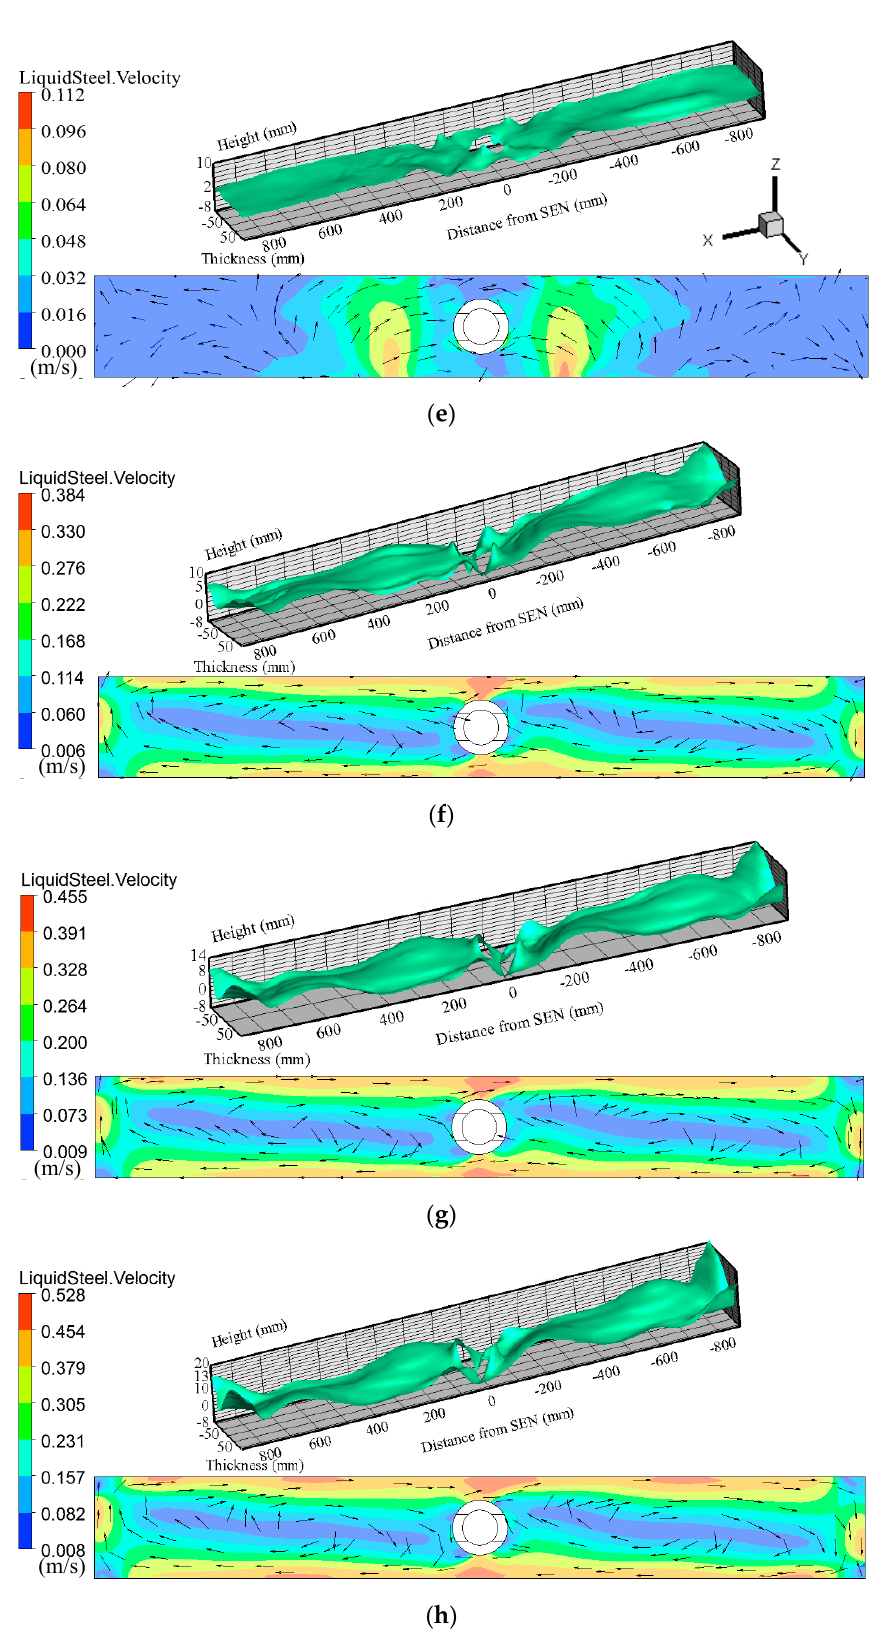
Figure 6. Level profile and surface velocity in the slab mold under different electromagnetic conditions. Time: 10 s; ( a ) 0 A; ( b ) 400 A; ( c ) 500 A; ( d ) 600 A; ( e ) 0 A + 0.3 T; ( f ) 400 A + 0.3 T; ( g ) 500 A + 0.3 T; ( h ) 600 A + 0.3 T.